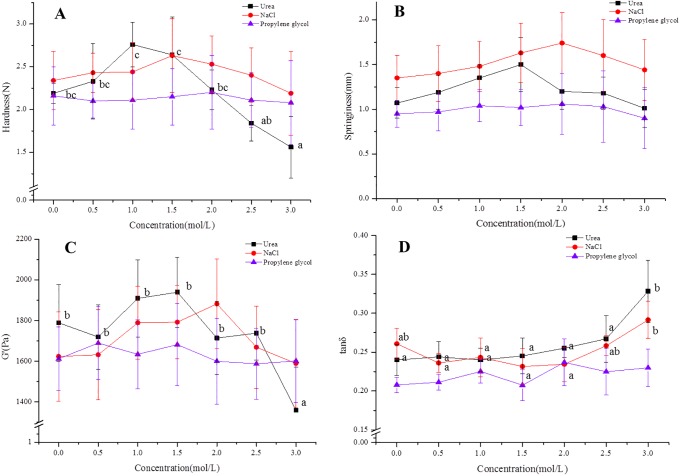
FESEM images of the β-glucan (mixed) gel prepared at different pressure with varying total concentrations and ratios.(A) 12%-0.1MPa, OG:LOG = 0:100. (B) 15%-200 MPa, OG:LOG = 50:50. (C) 12%-400MPa, OG:LOG = 50:50. (D) 15%-400MPa, OG:LOG = 50:50. (E) 12%-500MPa, OG:LOG = 50:50. (F) 12%-0.1MPa, OG:LOG = 100:0. The red arrows represent the holes.